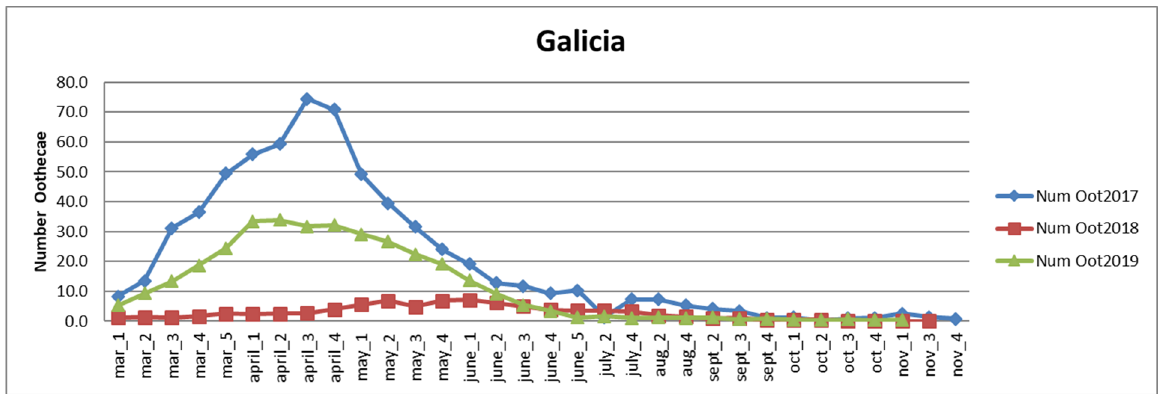
Figure 12. Number of oothecae according to the week in the sampling month (survey).